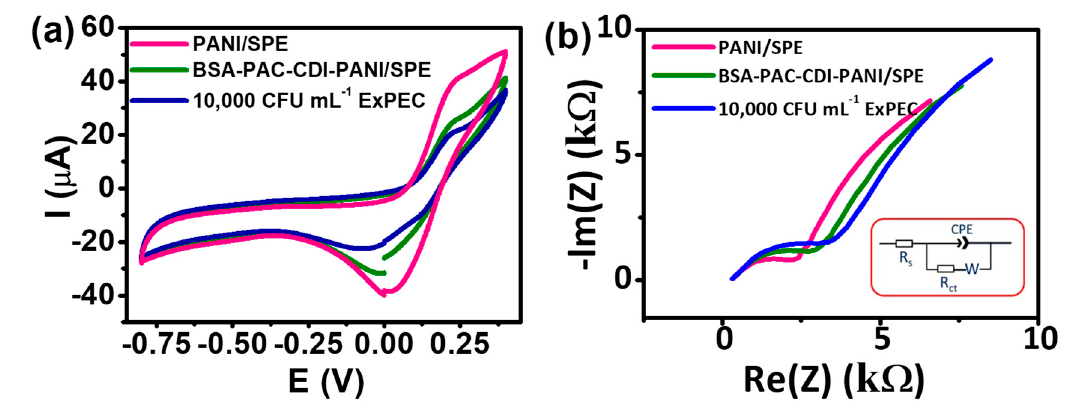
Figure 5. CV ( a ) and EIS spectra ( b ) of PANI/SPE, BSA-PAC-CDI-PANI/SPE, and 10,000 CFU mL − 1 ExPEC in 0.1 M KCl solution containing 5 mM [Fe(CN) 6 ] 3-/4- . The inset of ( b ) shows an equivalent circuit model. Table 1. Components of Randles equivalent circuit at various stages of surface modifications of the SPE. Sample